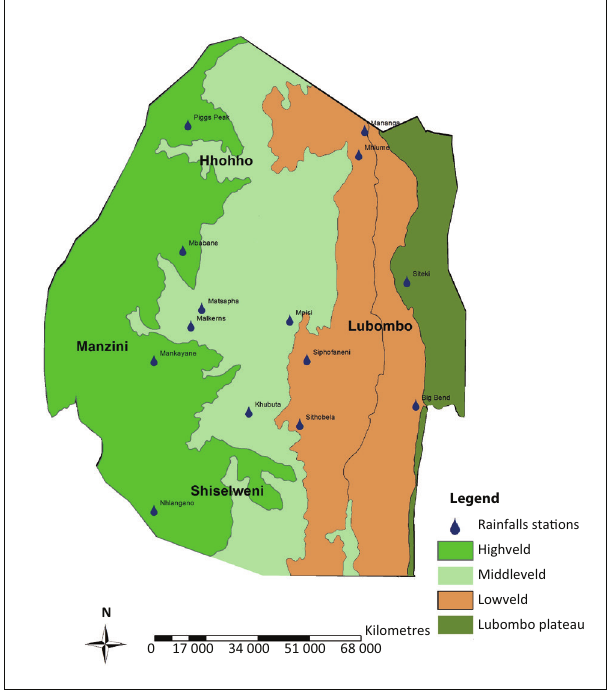
Legend Rainfalls sta(cid:22)ons Highveld Middleveld